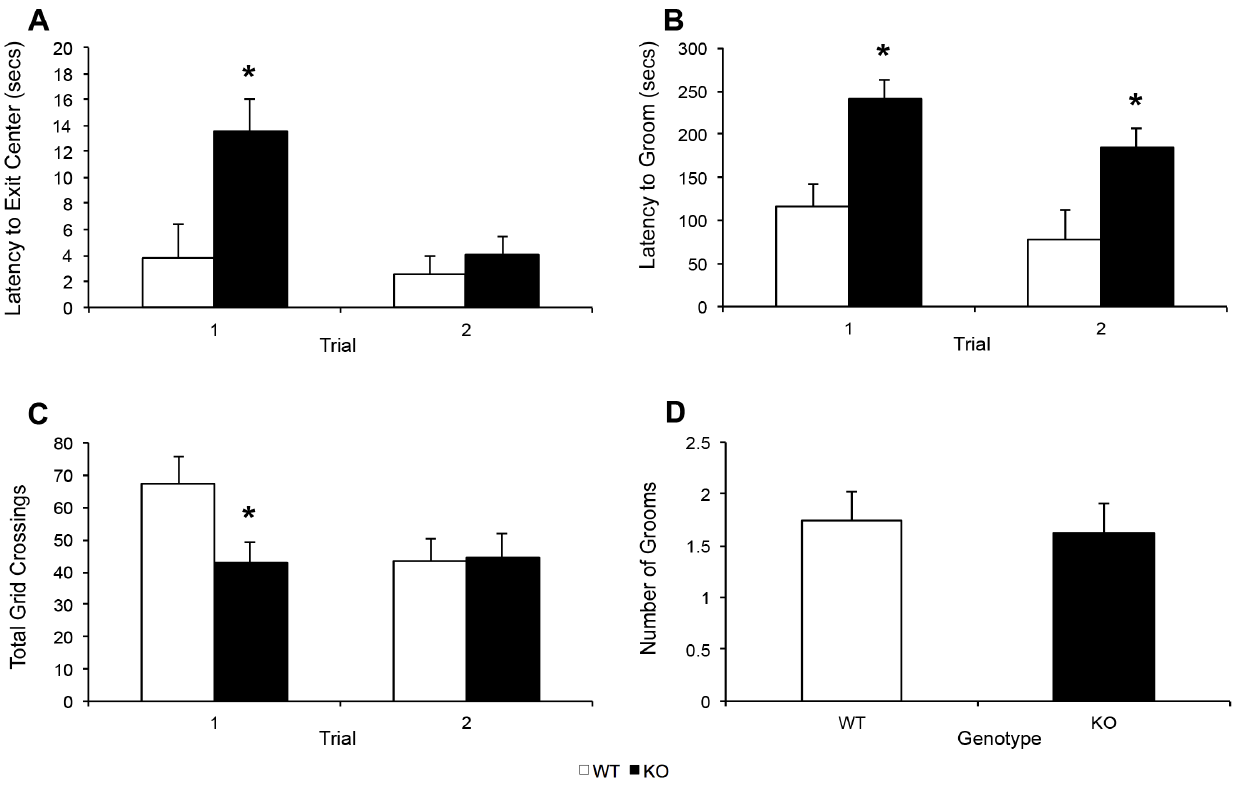
Figure 2. Open field behavior in PTN KOs and WTs. (a) Latency to exit the center grid, (b) latency to groom, (c) total grid crosses, and (d) number of grooms for KOs (n=9) and WTs (n=5). *p= , 0.05.